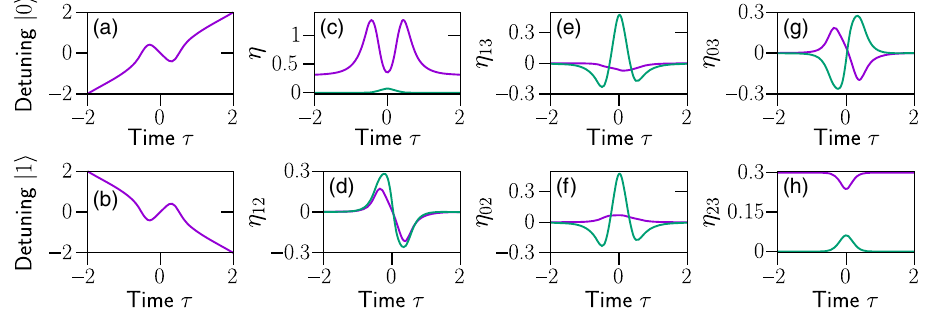
FIG. 9. Real (purple lines) and imaginary (green lines) parts of the controls predicted by the Magnus-based algorithm for the MLZ model as a function of time τ for η ¼ η 12 ¼ η 03 ¼ η 23 ¼ 0 . 3 and ω 2 ¼ ω 3 ¼ 0 . 1 . (a) Detuning of j 0 i . (b) Detuning of j 1 i . (c) Coupling η between the qubit states j 0 i and j 1 i . (d) Coupling between j 1 i and the leakage level j 2 i . (e) Coupling between j 1 i and the leakage level j 3 i . (f) Coupling between j 0 i and the leakage level j 2 i . (g) Coupling between j 0 i and the leakage level j 3 i . (h) Coupling between the leakage levels j 2 i and j 3 i